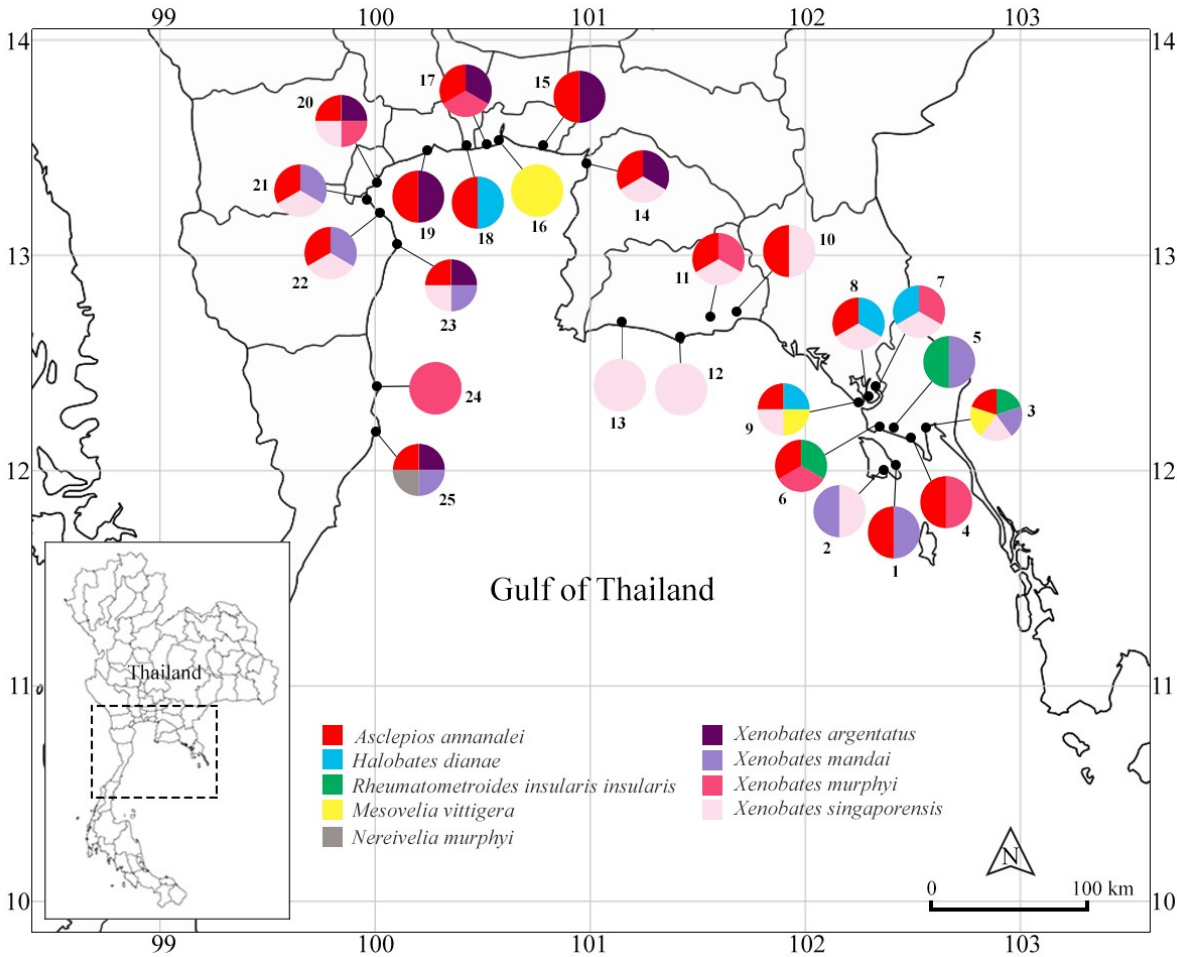
Figure 1. Map showing species richness and distribution of gerromorphans in mangroves of central and eastern regions, Thailand. Species are color-coded. Numbers refer to collecting sites (see Table 1).